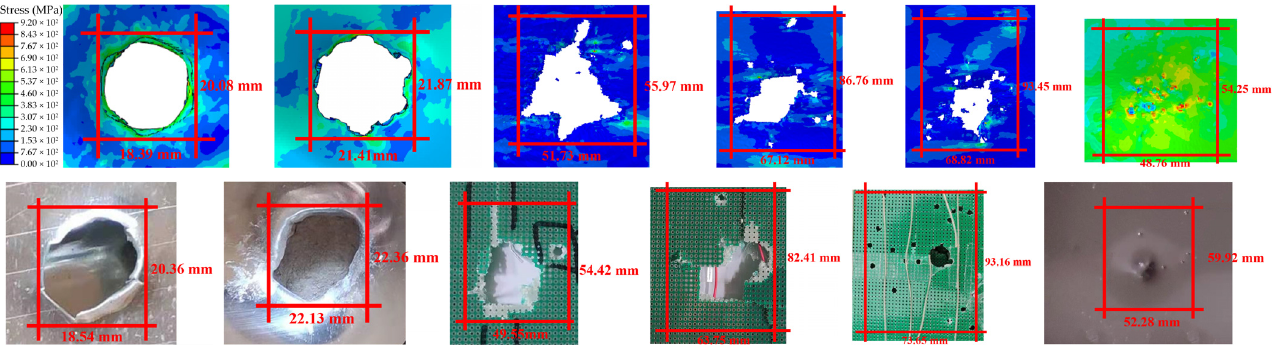
Figure 5. Simulation results of the projectile damage.